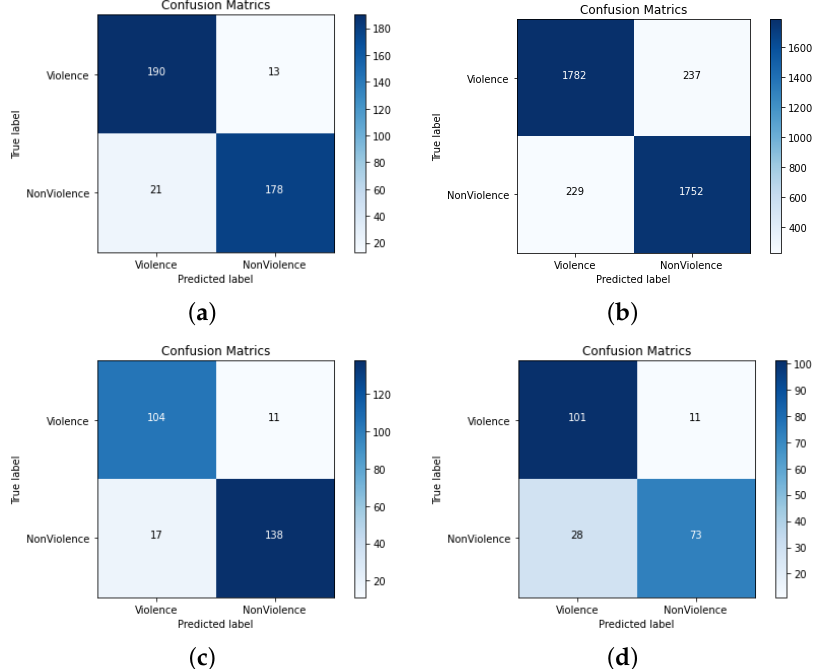
Figure 7. Confusion matrices of the proposed deep features attention model for VD using various benchmark datasets. ( a ) Hockey fight; ( b ) RWF-2000; ( c ) Violent crowd; ( d ) Surveillance fight.